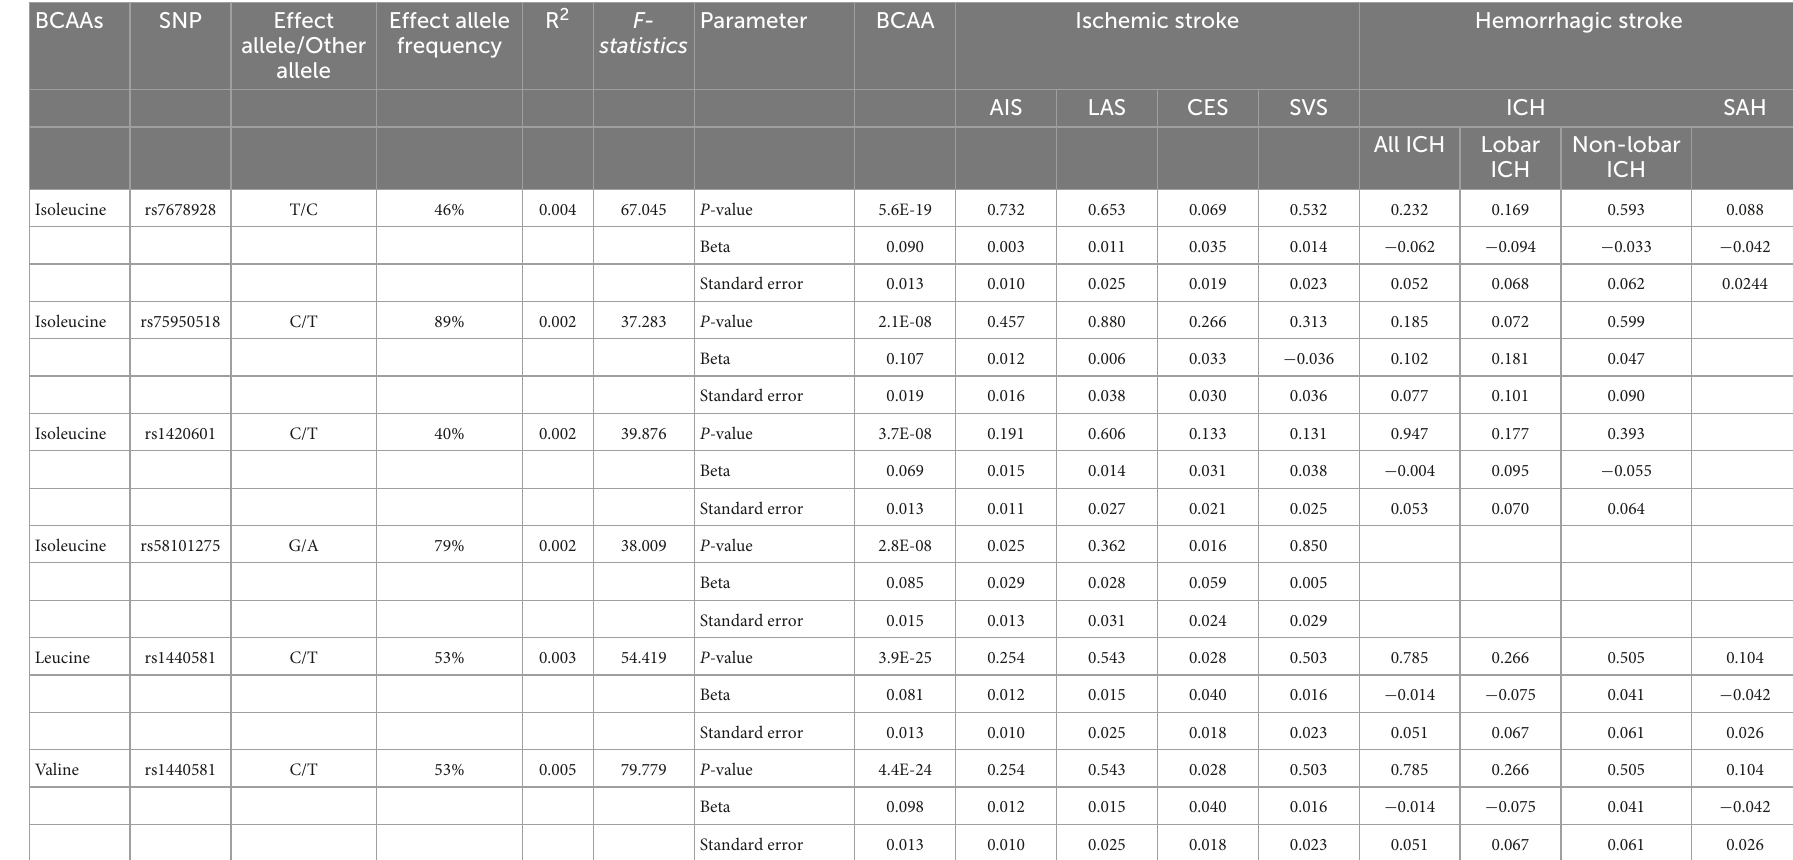
TABLE 2 Characteristics of the SNPs associated with BCAAs and stroke.